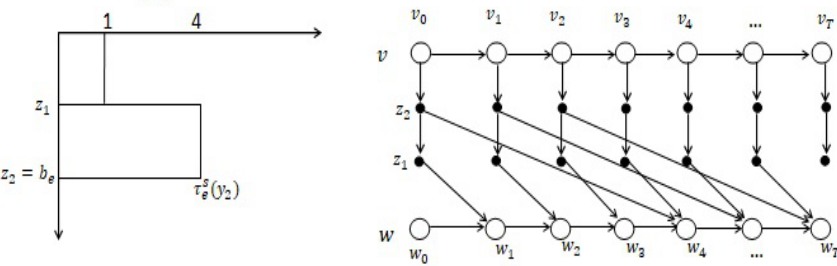
Figure 6: Expansion of a single arc e = ( v; w ) in the fan network with travel times 1 and 4, for at most z 1 and z 2 flow units, respectively. All arcs except the regulating are of infinite